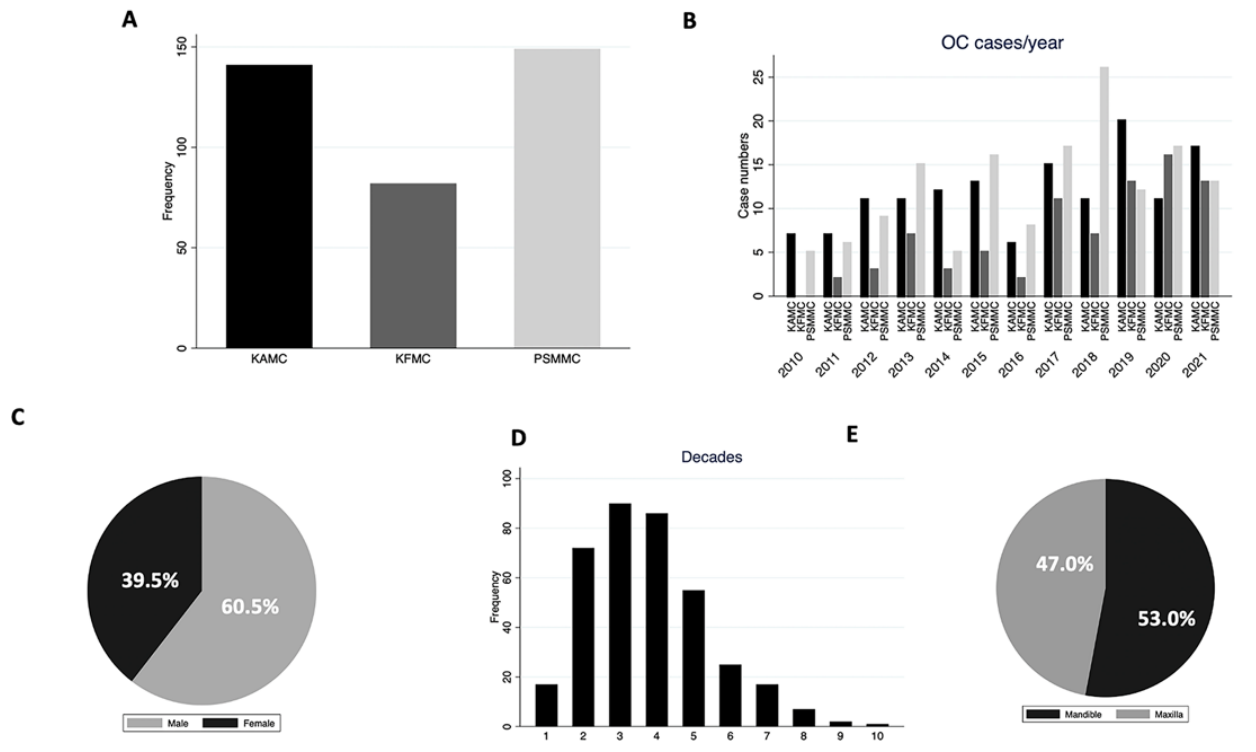
Figure 2. ( A ) OC distribution at each center. ( B ) Distribution of OCs at each center per year. PSMCC had the highest frequency in 2018. ( C ) Gender distribution of OCs. ( D ) Age distribution of OCs ( E ) Location distribution of OCs. Table 3. Summary of demographic in three different centers.